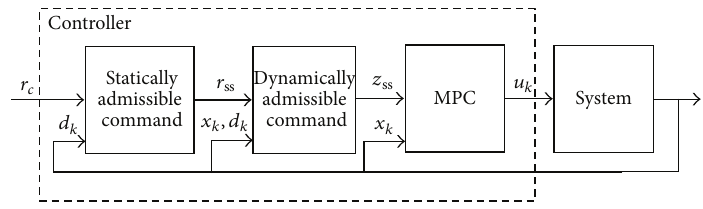
Figure 2: Overall scheme of the offline feasible MPC.